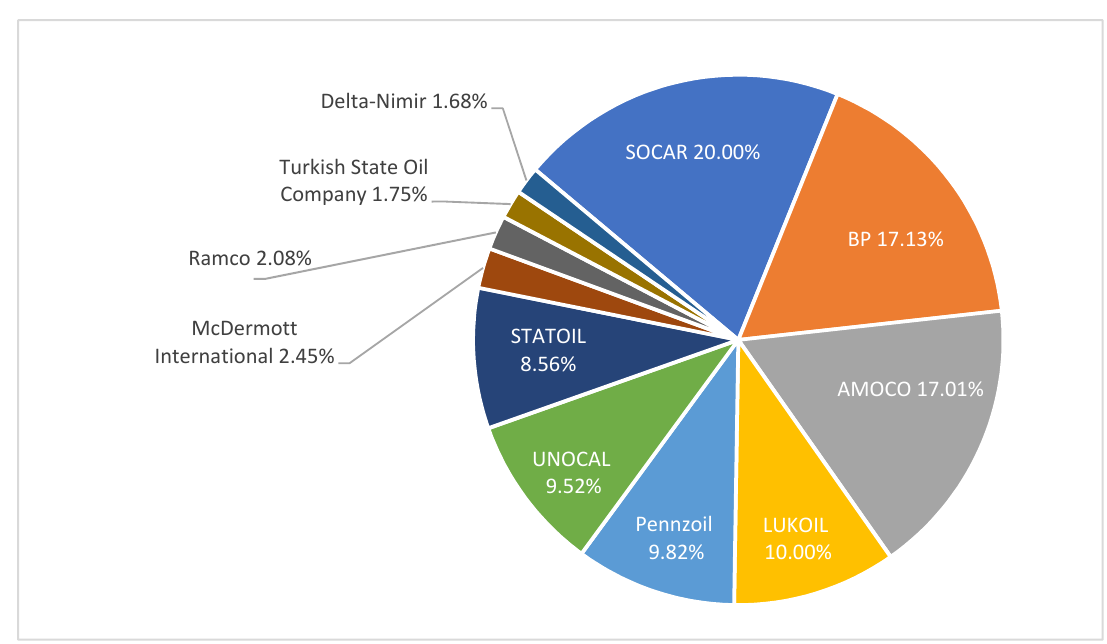
Figure 2. Shares of companies in the Contract of the Century in Azerbaijan (1994) [16].